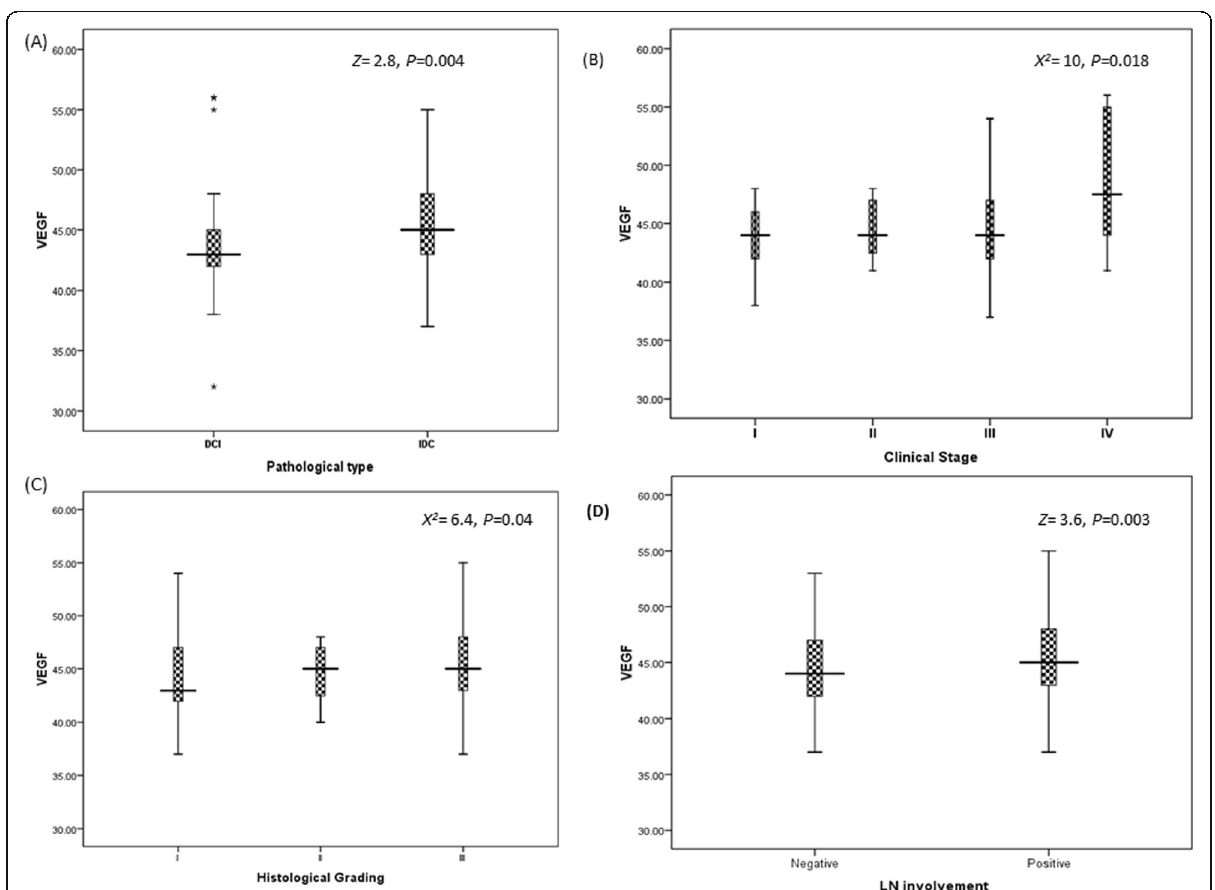
Fig. 3 Relation between VEGF and clinico-pathological features. a Pathological types (DCI vs IDC) at Z =2.8 ( P =0.004). b Clinical stages (stage I to IV) at X 2 =10 ( P =0.018). c Histological grading (grade I to III) at X 2 =6.4 ( P =0.04). d Lymph node involvement (negative involvement vs positive involvement) ( Z =3.6, P =0.003). Statistical analysis was done using the non-parametric test; as for two variables, the Mann-Whitney U test ( Z -value) was used; and for more than two variables, the Kruskal-Wallis H test ( X 2 test) was used